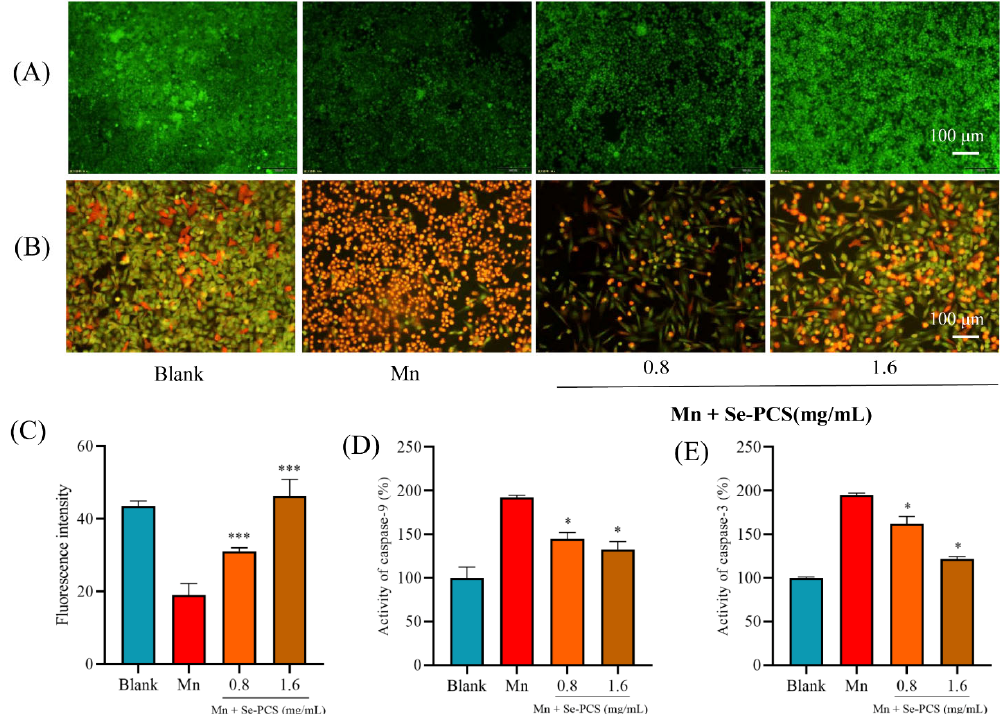
Figure 6. After treatment with Se ‐ PCS, ( A , C ) changes in MMP in Hep G2 cells and ( B ) cell apoptosis stained by AO/EB are shown. In the presence of MnCl 2 (1.6 Mm), the activities of ( D ) caspase ‐ 3 and ( E ) caspase ‐ 9 are shown; * and *** mean p < 0.05 and p < 0.001, respectively, compared with the Mn